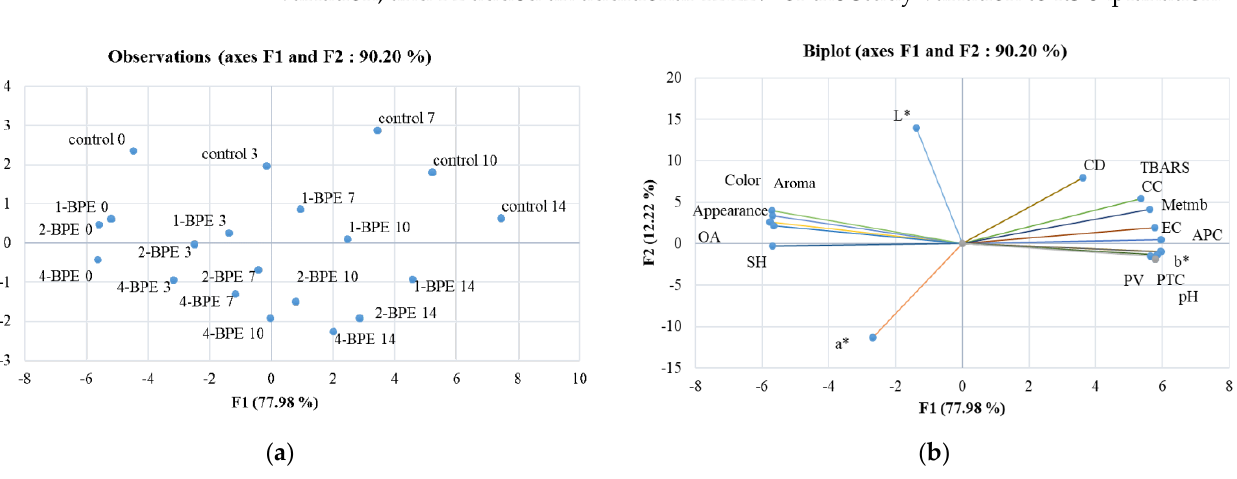
Figure 6. Loading plots of the two principal components (F1, F2) based on all samples (n=20) (a) and on physicochemical, microbial growth, color, and sensorial property values of meat samples over 14 days of storage (b).